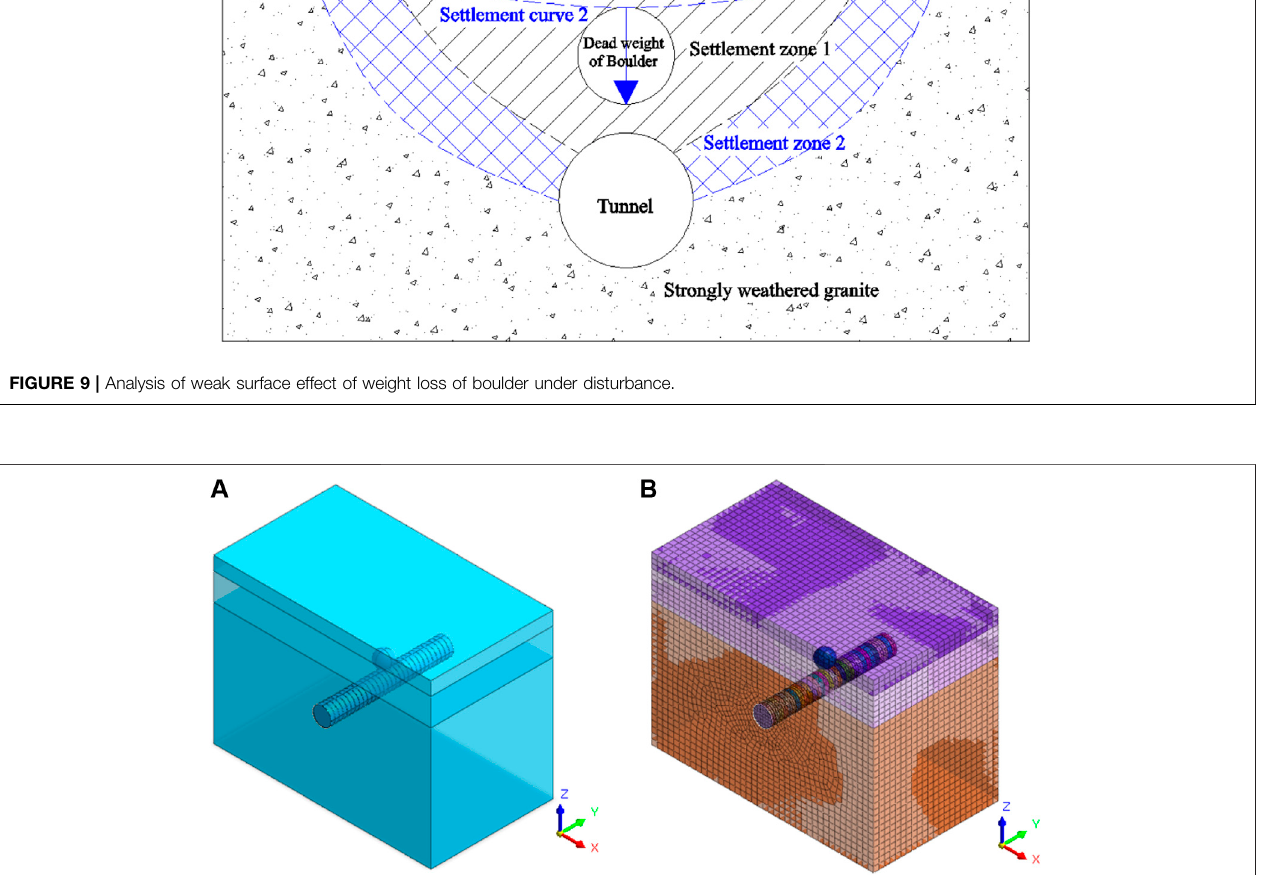
TABLE 2 | Physical and mechanical parameters of the lining structure. Formation